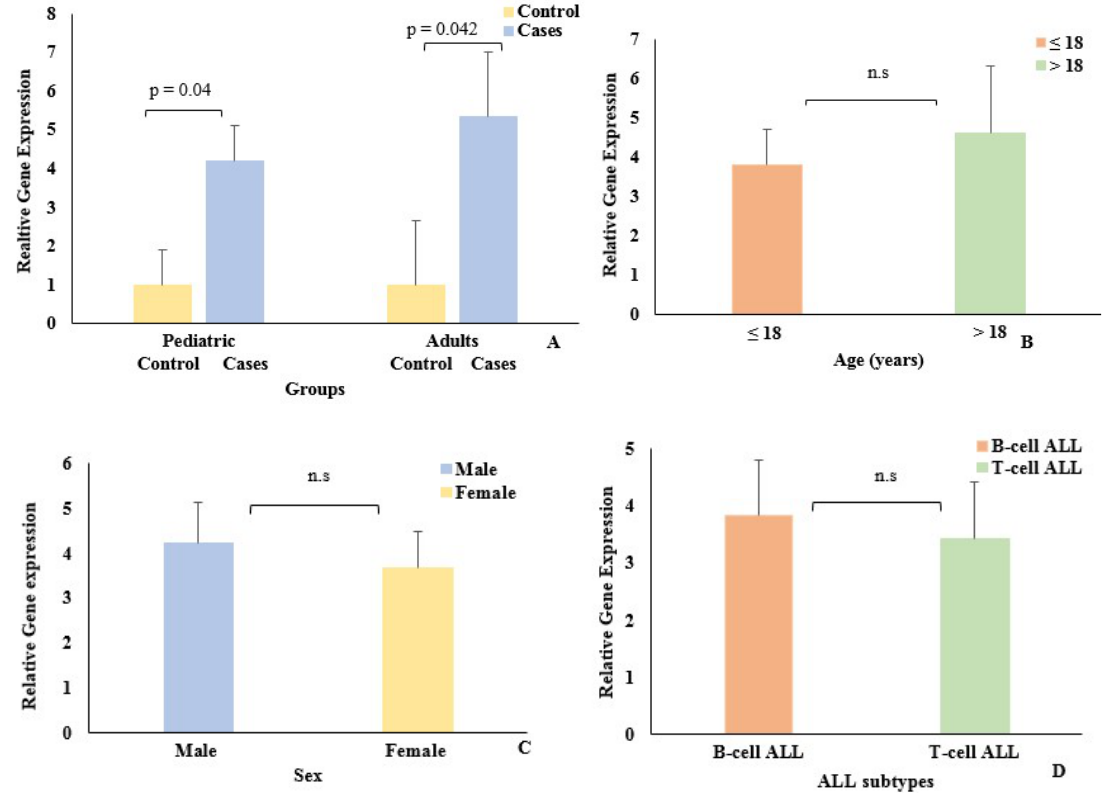
Figure 2. EpCAM expression in ( A ) ALL cases (pediatric and adults) and controls.( B ) Age group (pediatric ≤ 18 years, adults > 18 years);( C )Sex ;( D ) ALL subtype. n.s represents p values > 0.05 (t (pediatric ≤ 18 years, adults > 18 years); ( C ) Sex; ( D ) ALL subtype. n.s represents p values > 0.05 test). Error bars represent standard error of mean. ( t test). Error bars represent standard error of